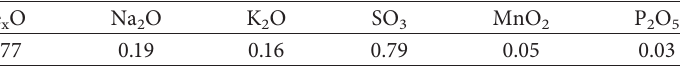
Table 1: Chemical compositions of the cement (wt.%).